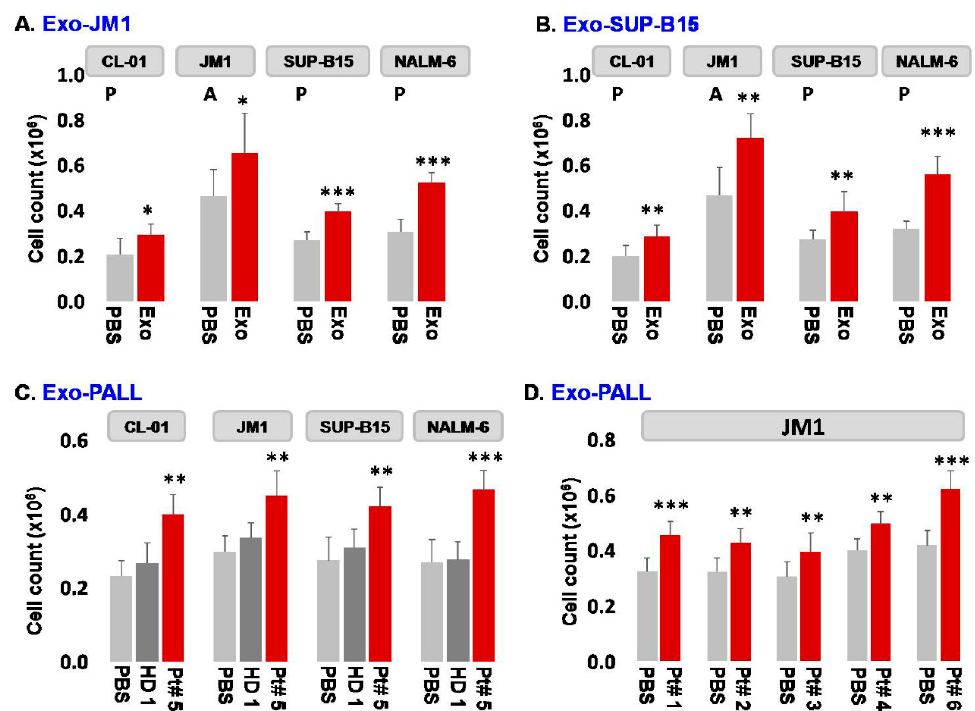
Figure 2. Exosomes from leukemia cell lines and from serum of pediatric ALL patients induce autocrine and paracrine cell proliferation in leukemia cell lines. ( A ) Exo-JM1-induced cell proliferation in control B cell line CL-01 and human leukemia cell lines JM1, SUP-B15, and NALM-6. ( B ) Exo-SUP-B15 - induced cell proliferation in control B cell line CL-01 and human leukemia cell lines JM1, SUP-B15, and NALM-6. ( C ) Exosomes derived from human serum of ALL patient #5 (Exo-PALL) at day 1 diagnosis induce proliferation in CL-01, JM1, SUP-B15, and NALM-6 cells compared to healthy donor exosomes (HD) or control PBS treated only. ( D ) Human serum exosomes (Exo-PALL) derived from the five different patients (Pt #1, 2, 3, 4 and 6) induce cell proliferation in JM1 cells compared to control PBS group. ( PBS: control — no exosomes; P: paracrine effect ; A: autocrine effect. Mean of 3 experiments. p- value * p < 0.05, ** p < 0.01, *** p < 0.001 ).